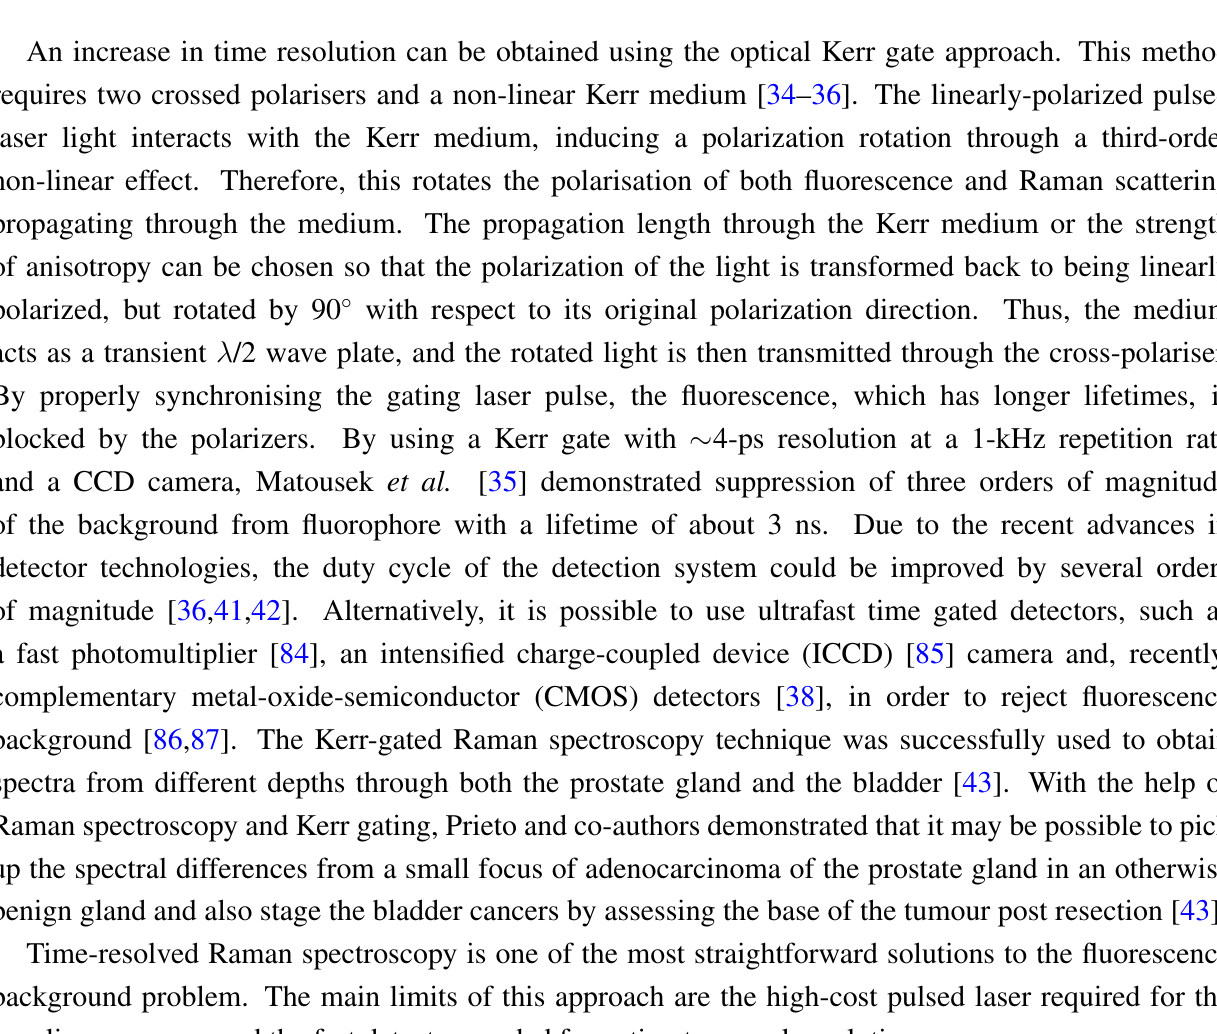
( a ) Energy level diagram for Raman scattering and fluorescence emission; ( b ) temporal variation of excitation, Raman scattering and fluorescence